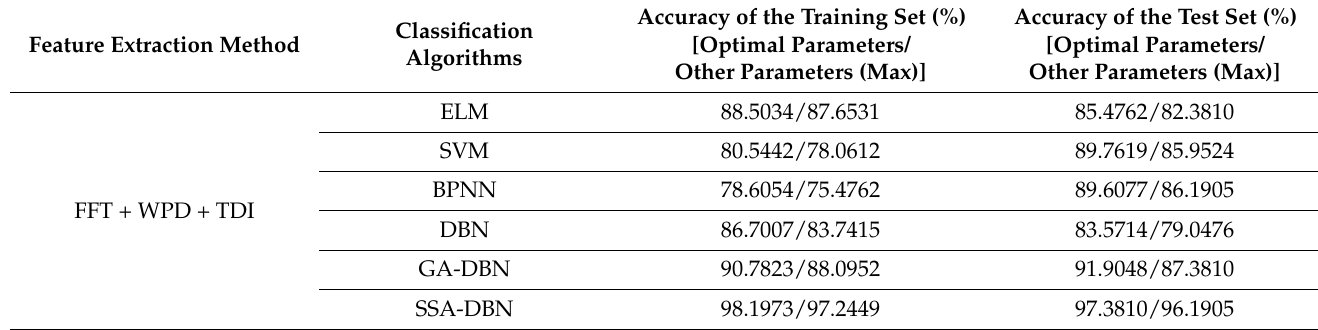
Table A4. The influence of parameter settings on the results of the extended